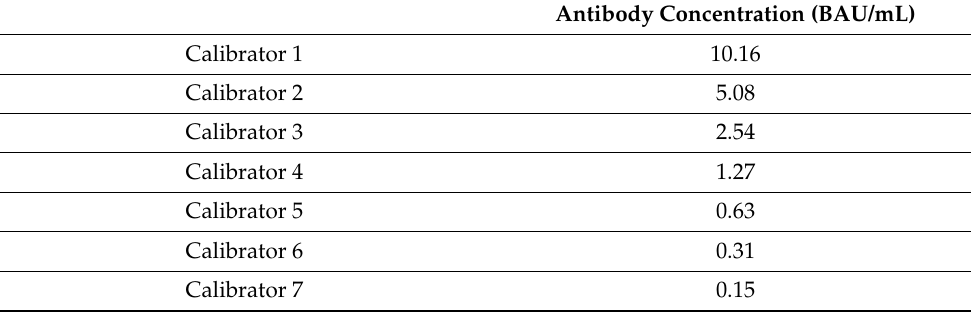
Table 2. Calibrator values for the anti-N protein IgG